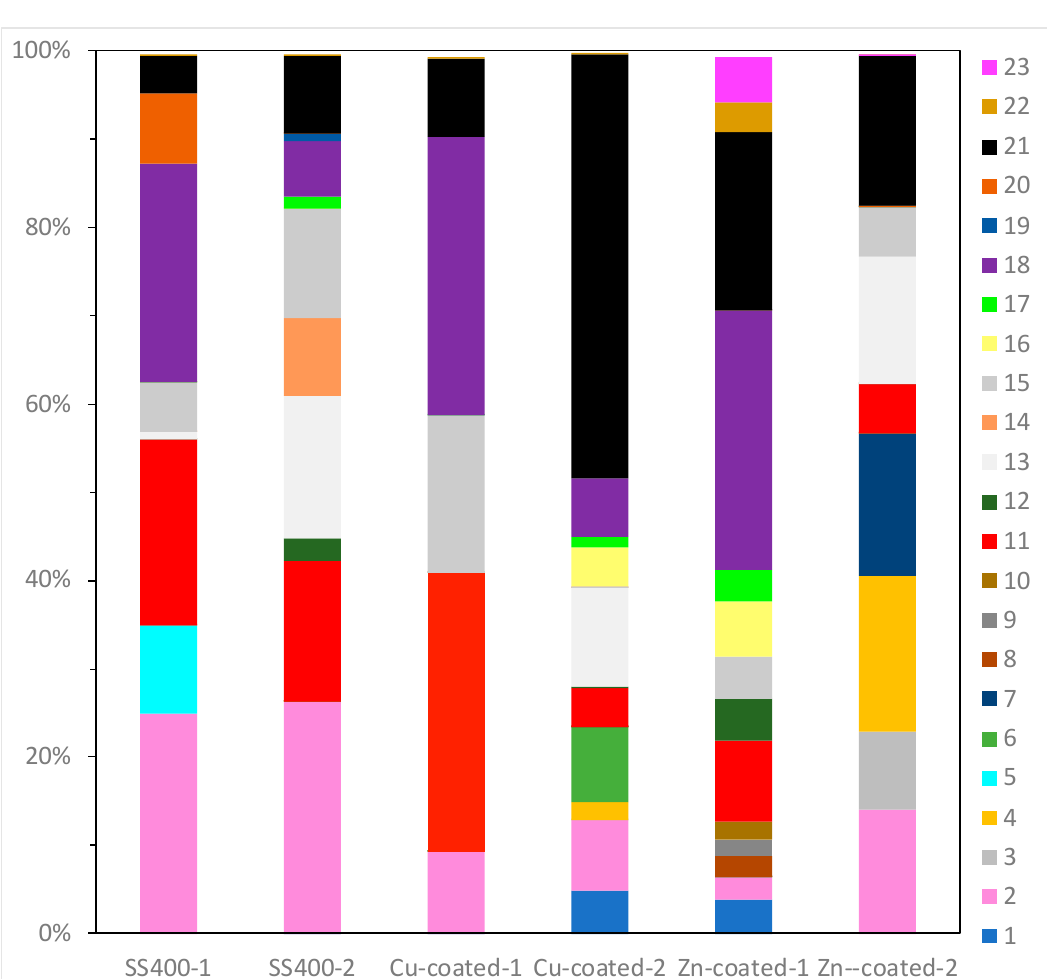
Figure 8. OTU abundance percentages of outdoor-exposed coupons. Bacterial orders present at <1.0% and unassigned OTUs are excluded from each column. (1) Unknown member of Acidobacteria-5; (2)